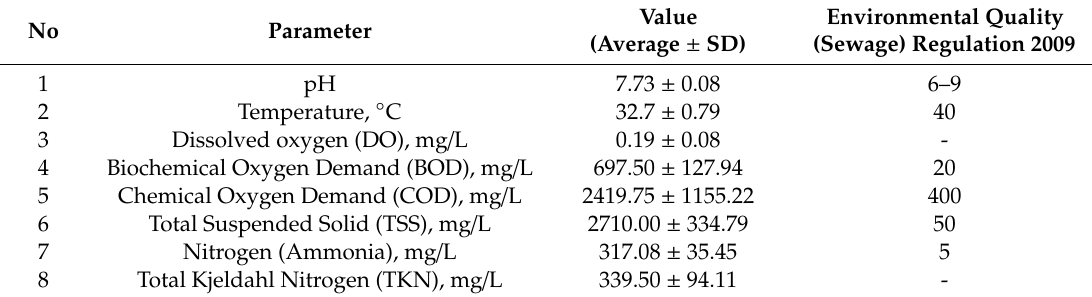
Table 6. Raw leachate